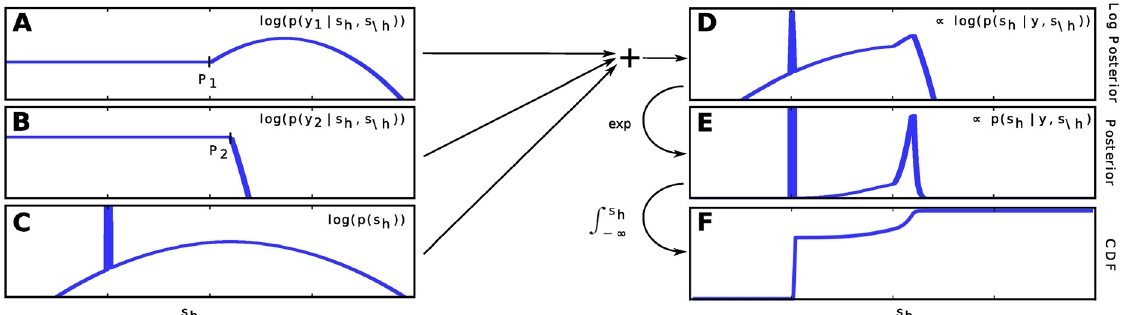
Fig 3. Construction of SSMCA-induced posterior for the Gibbs sampler. Left column: three contributing factors for the posterior / p ( s h j s n h , y , Θ ) in log space. A and B : Log likelihood functions each defined by a transition point P d and left and right pieces r d ( s h ) and l d ( s h ). C Log prior, which consists of an overall Gaussian and the Dirac-peak at s h = 0. D Log posterior, the sum of functions A , B , and C consists of D + 1 pieces plus the Dirac-peak at s h = 0. E Exponentiation of the D log posterior. F CDF for s h from which we do inverse transform sampling.